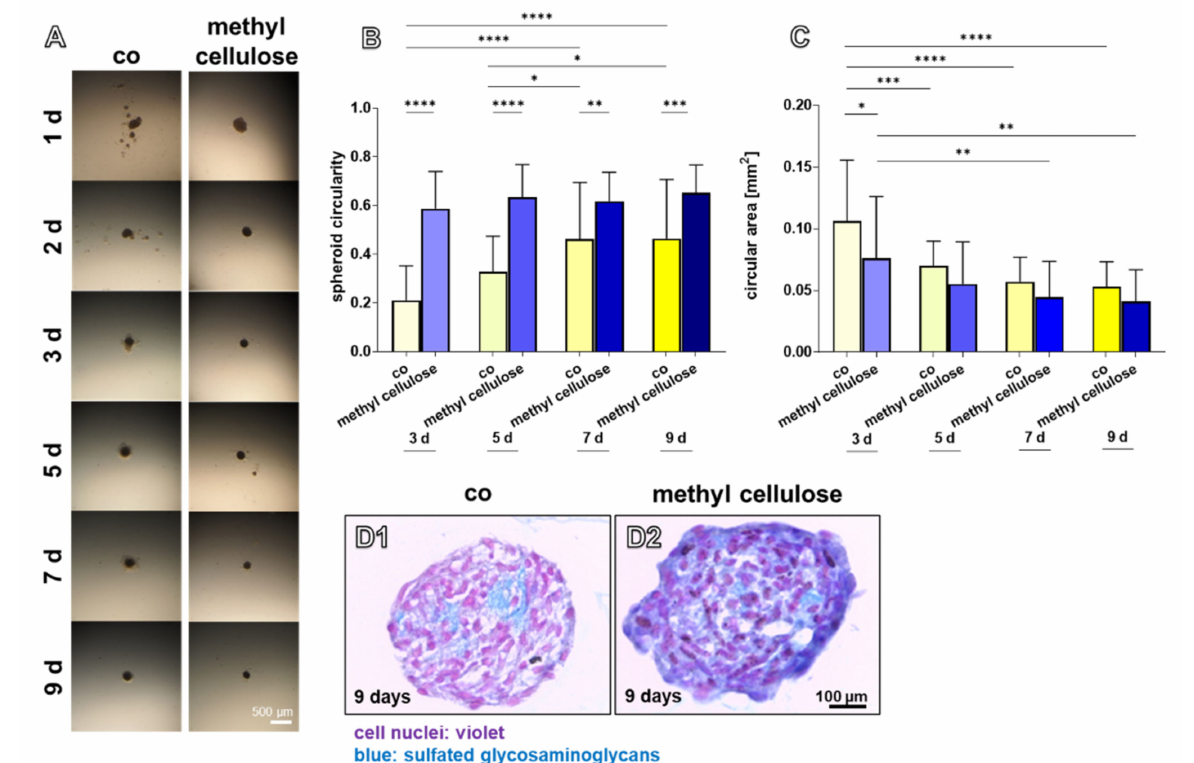
Figure 7. Effect of methyl cellulose on spheroids produced with the HD methods and monitored for 9 days. ( A ) native spheroids are shown after different culturing days in hanging drops (1–3, 5, 7, and 9 days). ( B ) spheroid circularity, ( C ) circular area (co: control, yellow bars). ( D1–2 ) Alcian blue staining of a central section of the control ( D1 ) spheroids and those ( D2 ) treated with methyl cellulose. Spheroids consisted of 1 × 10 4 cells. 10 spheroids per day and per experiment were analyzed. Representative images are shown derived from three independent experiments. Scale bars: 500 µ m ( A ), 100 µ m ( D1 , D2 ). Statistics: n = 3 independent experiments were performed with cells of three different donors. One-way ANOVA (Tukey’s multiple comparisons test) for comparison between groups. p values: * <0.05, ** <0.01, *** <0.001, **** < 0.0001 ( B , C